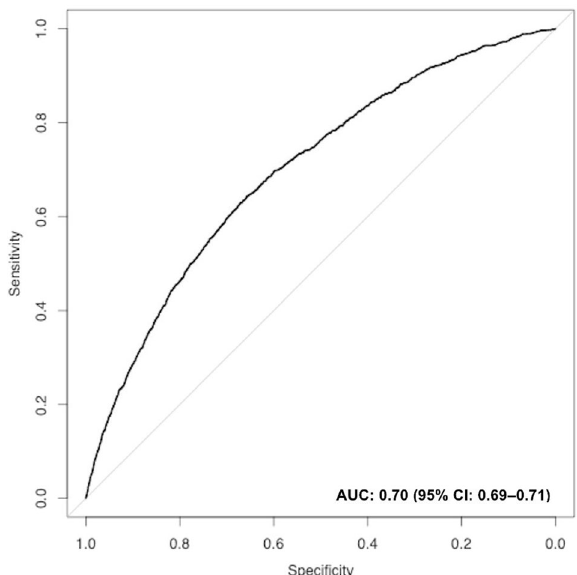
Fig. 1 Suicide prediction model discrimination as demonstrated by a receiver operating characteristics curve (ROC; sensitivity against 1-speci fi city) in the Finnish external validation sample of individuals with severe mental illness ( n = 137,112). The area under the ROC curve (AUC) is presented with its 95% con fi dence intervals.